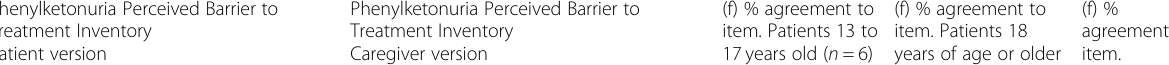
Table 4 Frequency of responses to perceived barrier to Phenylketonuria treatment by groups of adolescents, adult patients and caregivers of patients (6 to 17